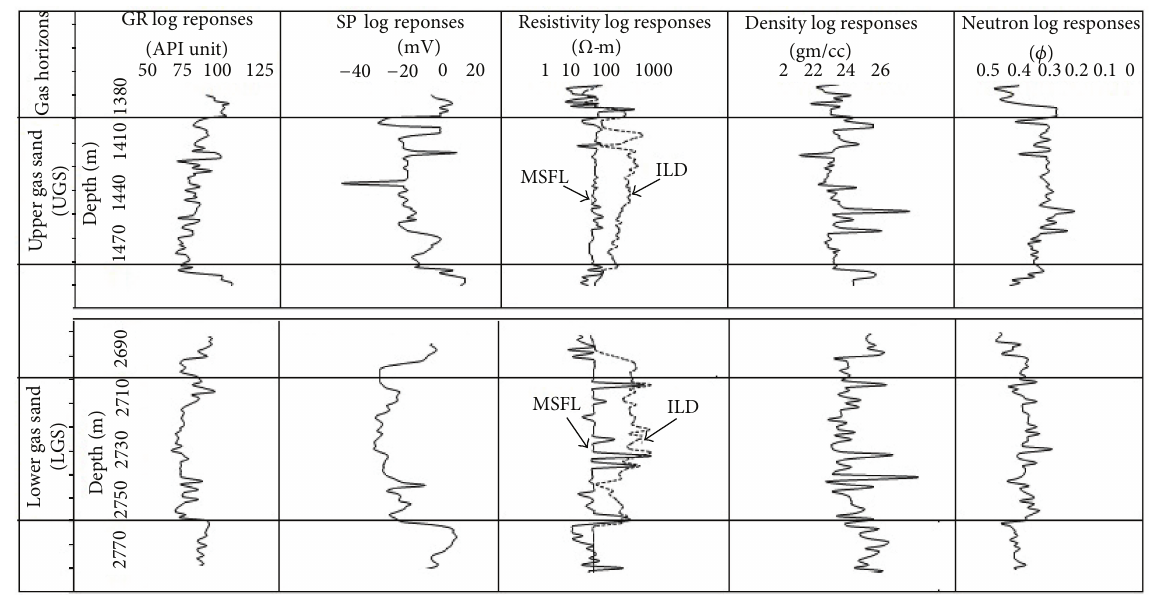
Figure 10: Composite well log responses in the gas sand horizons of the well RP #4 (after Islam et al. [15]).